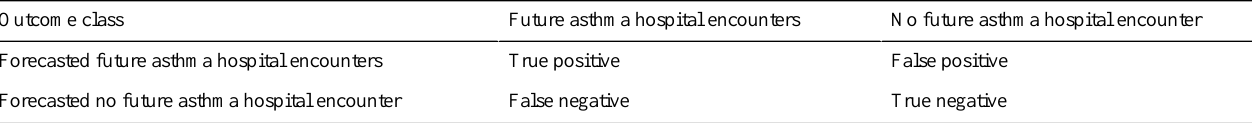
Table 1. The confusion